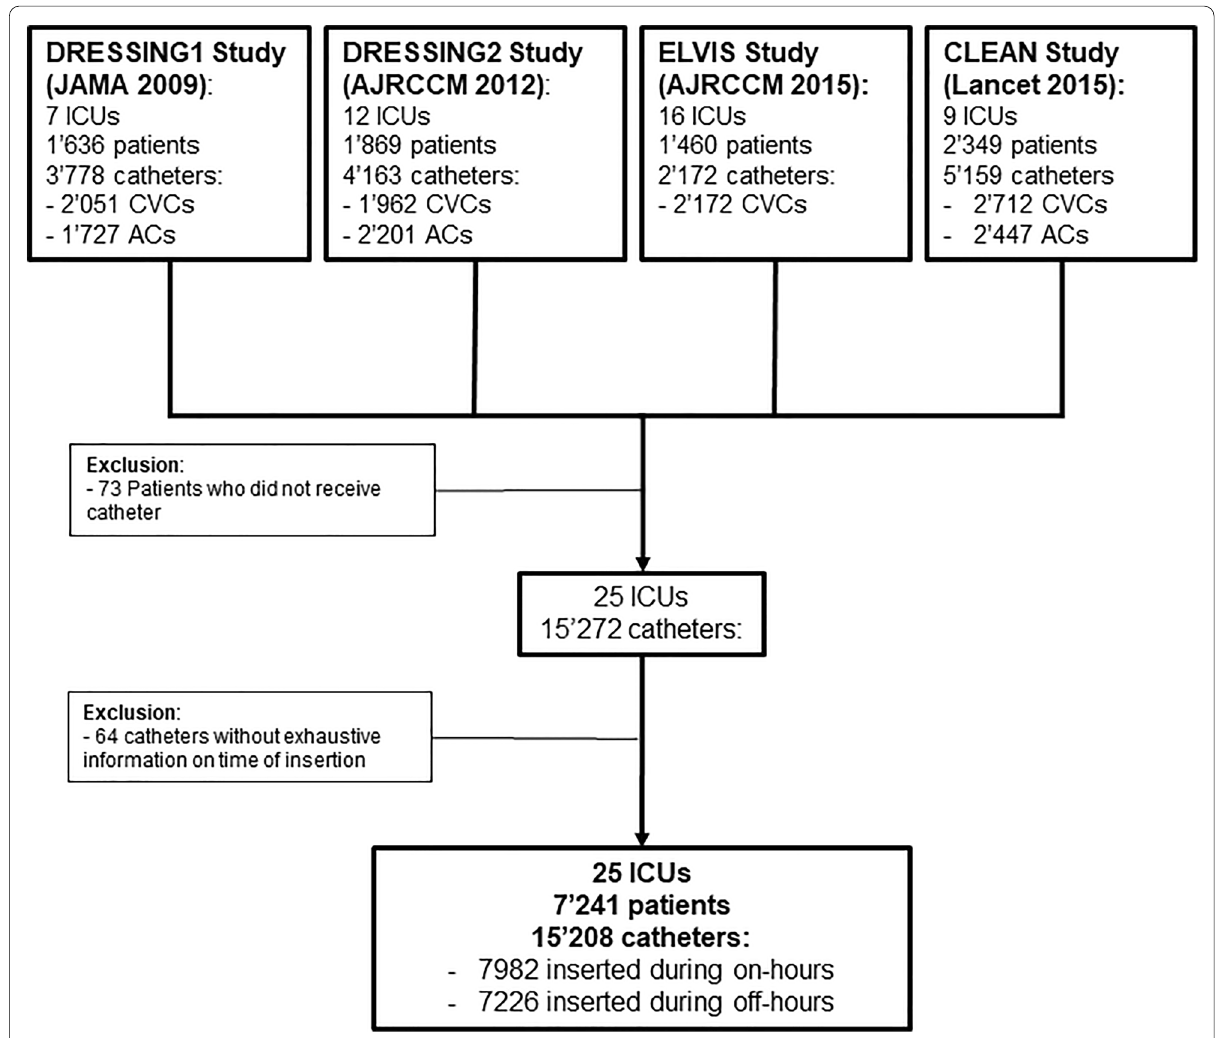
Fig. 1 Flowchart. ICU: intensive care unit. CVC: central venous catheters and short‑term dialysis catheters. AC: arterial